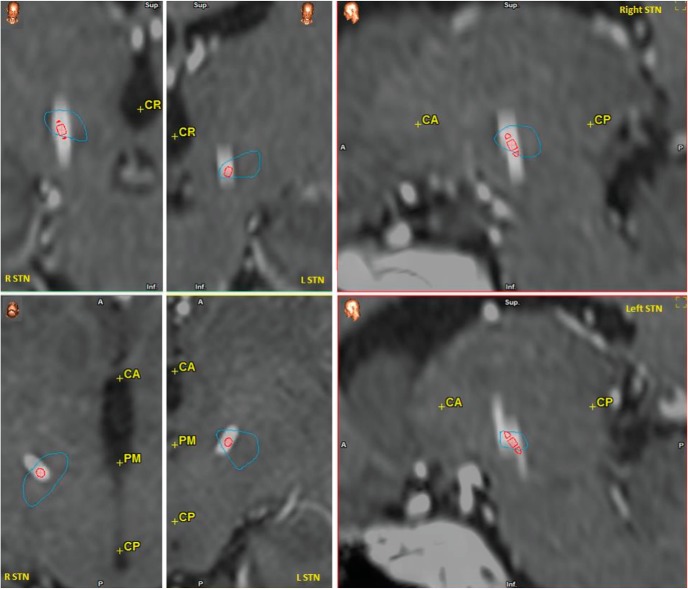
2D reconstruction of recording coordinates. Location of STN (pale blue lines) and of Medtronic 3389 DBS contact 1 in GDP #6 (already shown in Fig. 1D). R, right; L, left; CA, anterior commissure; CP, posterior commissure; PM, middle point between CA and CP line; CO, MRI coronal view; SW, MRI sagittal view; AX, MRI axial (transverse) view; Sup, superior; Inf, inferior; A, anterior; P, posterior.